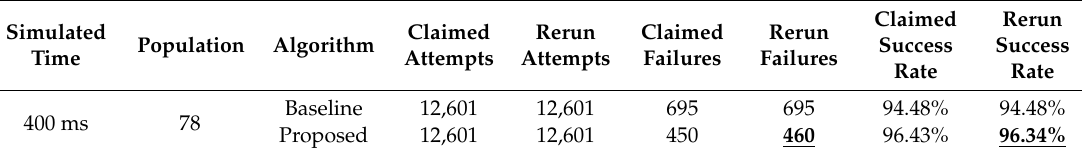
Table 8. Inconsistencies in results.